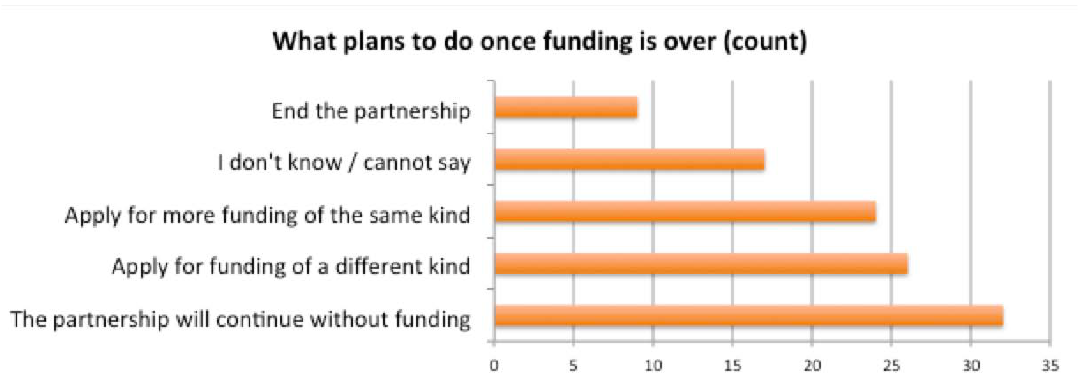
Figure 10. What partner organisations plan to do once funding for their museum university partnerships is over, as shown by survey data.